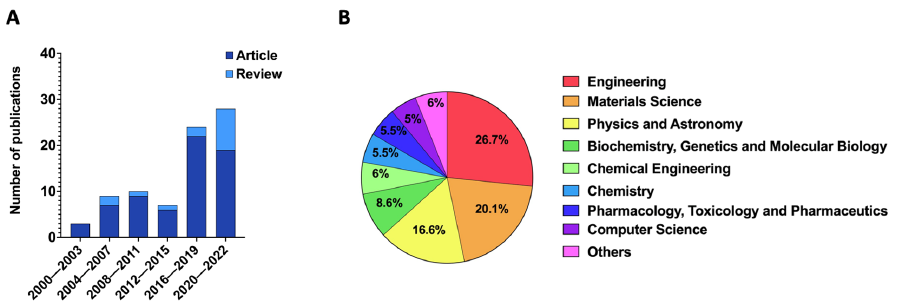
Figure 3. Metadata analysis of the keywords “MNs + microfluidic” and “MNs + organ-on-a-chip” and “MNs + Lab-on-a-chip” between 2000 and 2022. ( A ) Number of publications per combined years. ( B ) Documents by subject area.